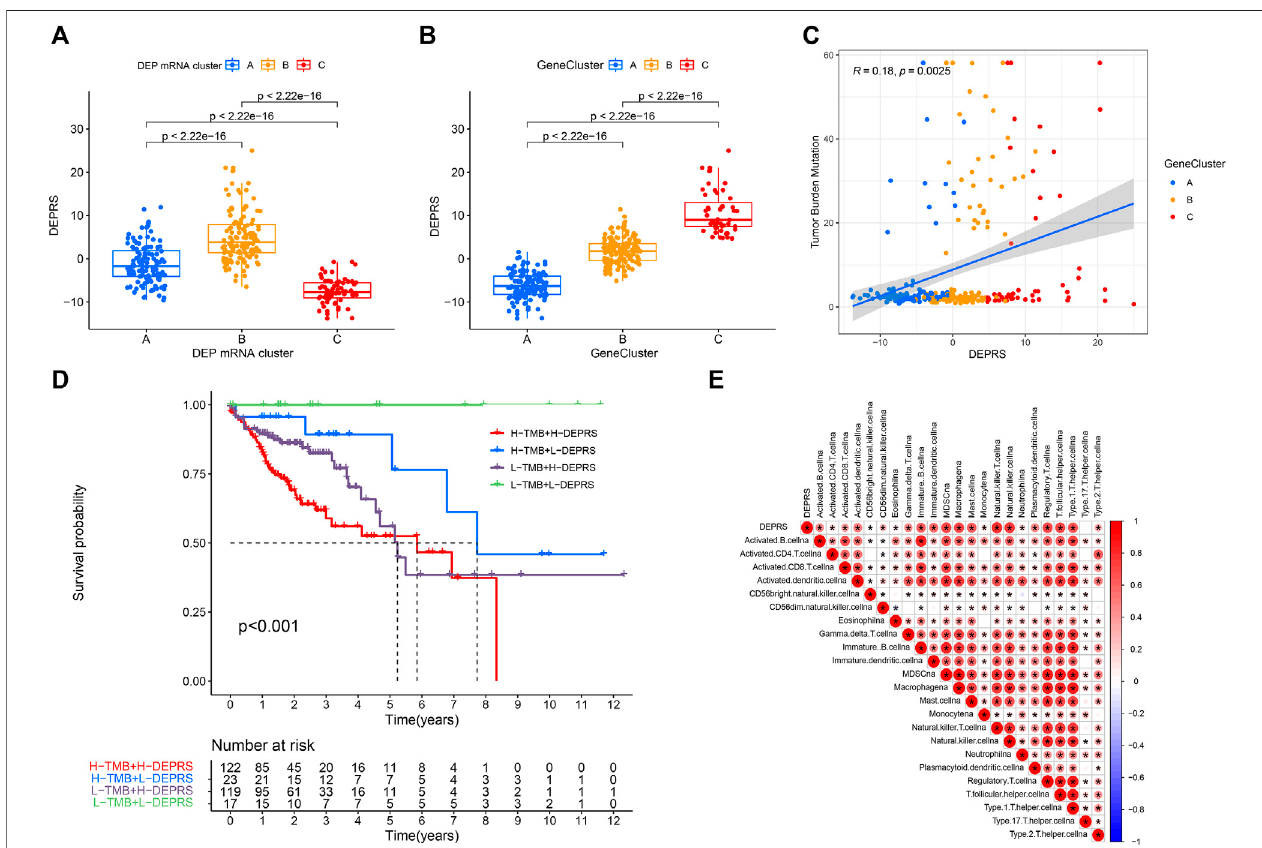
FIGURE 5 | (A) Differences in DEPSR among the three DEP mRNA clusters in TCGA cohort. Statistical comparisons were made using Kruskal-Wallis test ( p < 0.001). (B) Differences in DEPSR among three gene clusters in TCGA cohort. Statistical comparisons were made using Kruskal-Wallis test ( p < 0.001). (C) The scatterplotsshowpositivecorrelationbetweenDEPRSandTMB. TheSpearmancorrelationbetweenDEPRSandTMBwas0.18( p =0.0025). (D) Kaplan – Meiercurves showing the overall survival based on TMB and DEPRS. Log rank test, p < 0.001. (E) Correlations between DEPRS and the universal landscape of immune cell interaction in TME as determined using Spearman analysis. Negative correlation is shown in blue and positive correlation is shown in red.